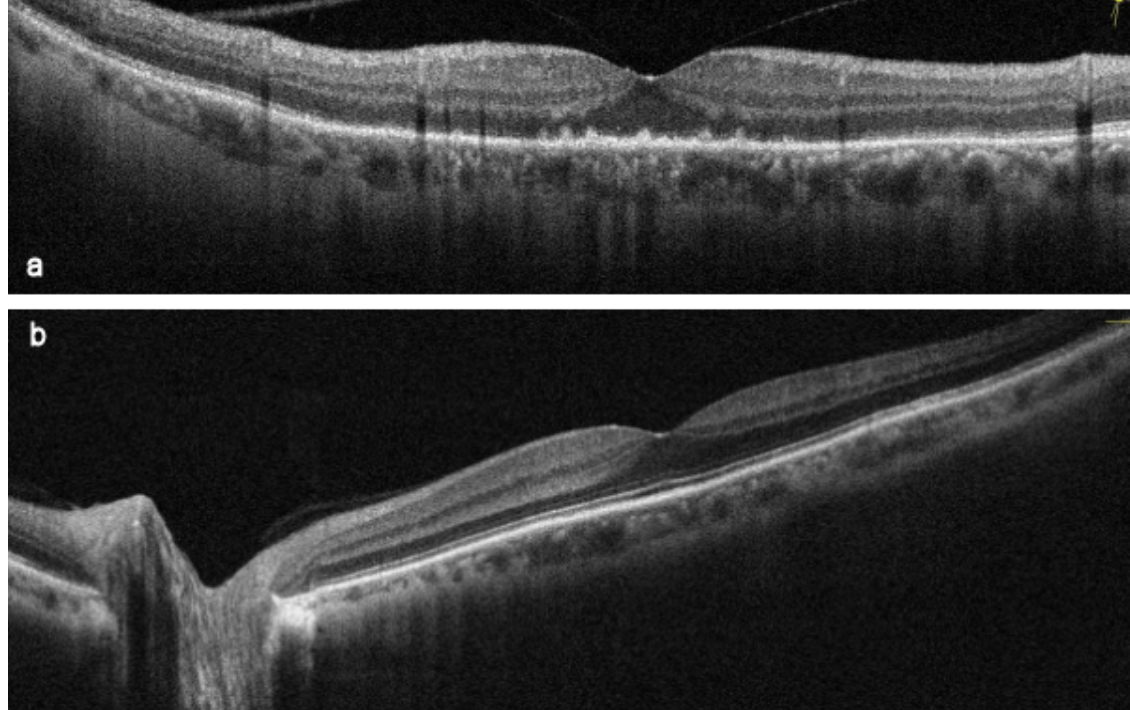
Figure 4: SD-OCT images at the time of diagnosis (a) Spectral domain optical coherence tomography (SD-OCT) revealed hyperreflective dots between RPE and the ellipsoid zone (EZ) and loss or irregularity of the EZ, (b) SD-OCT image of the left